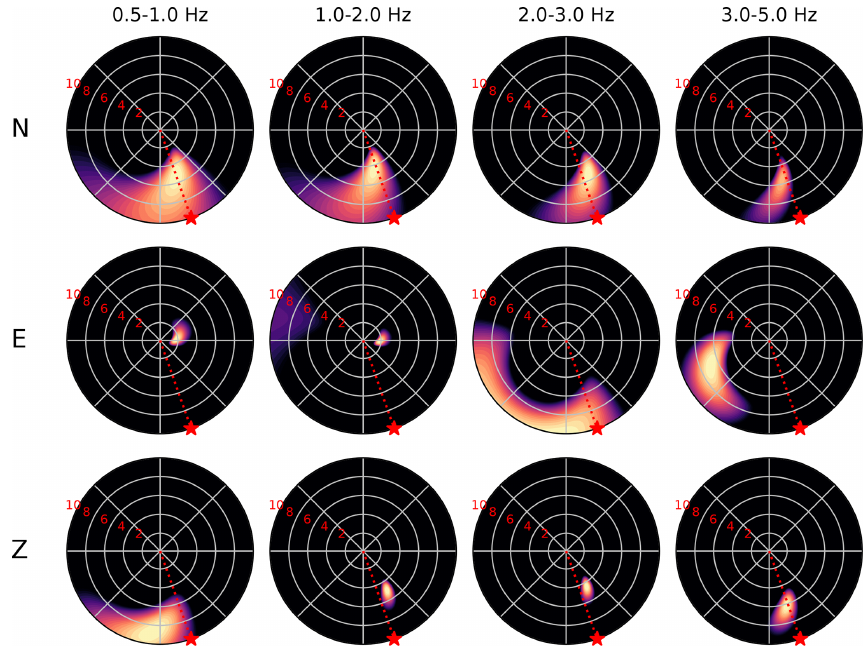
Figure 4. Beamforming results of the P waves recorded by the nodal array. Each panel shows the MUSIC pseudo-power for the candidate combination of azimuth and apparent velocity (reciprocal of slowness) normalised to lie between 0 and 1. For visual clarity we clip the colours at a normalised pseudo-power of 0.8 (i.e. at 80% of the maximum pseudo-power). The apparent velocity is plotted up to 10kms − 1 , with radial grid increments of 2kms − 1 (indicated by the red numbers). The frequency bands and components are indicated above each column and beside each row, respectively. The true back-azimuth of the source is indicated by a red star in each panel.